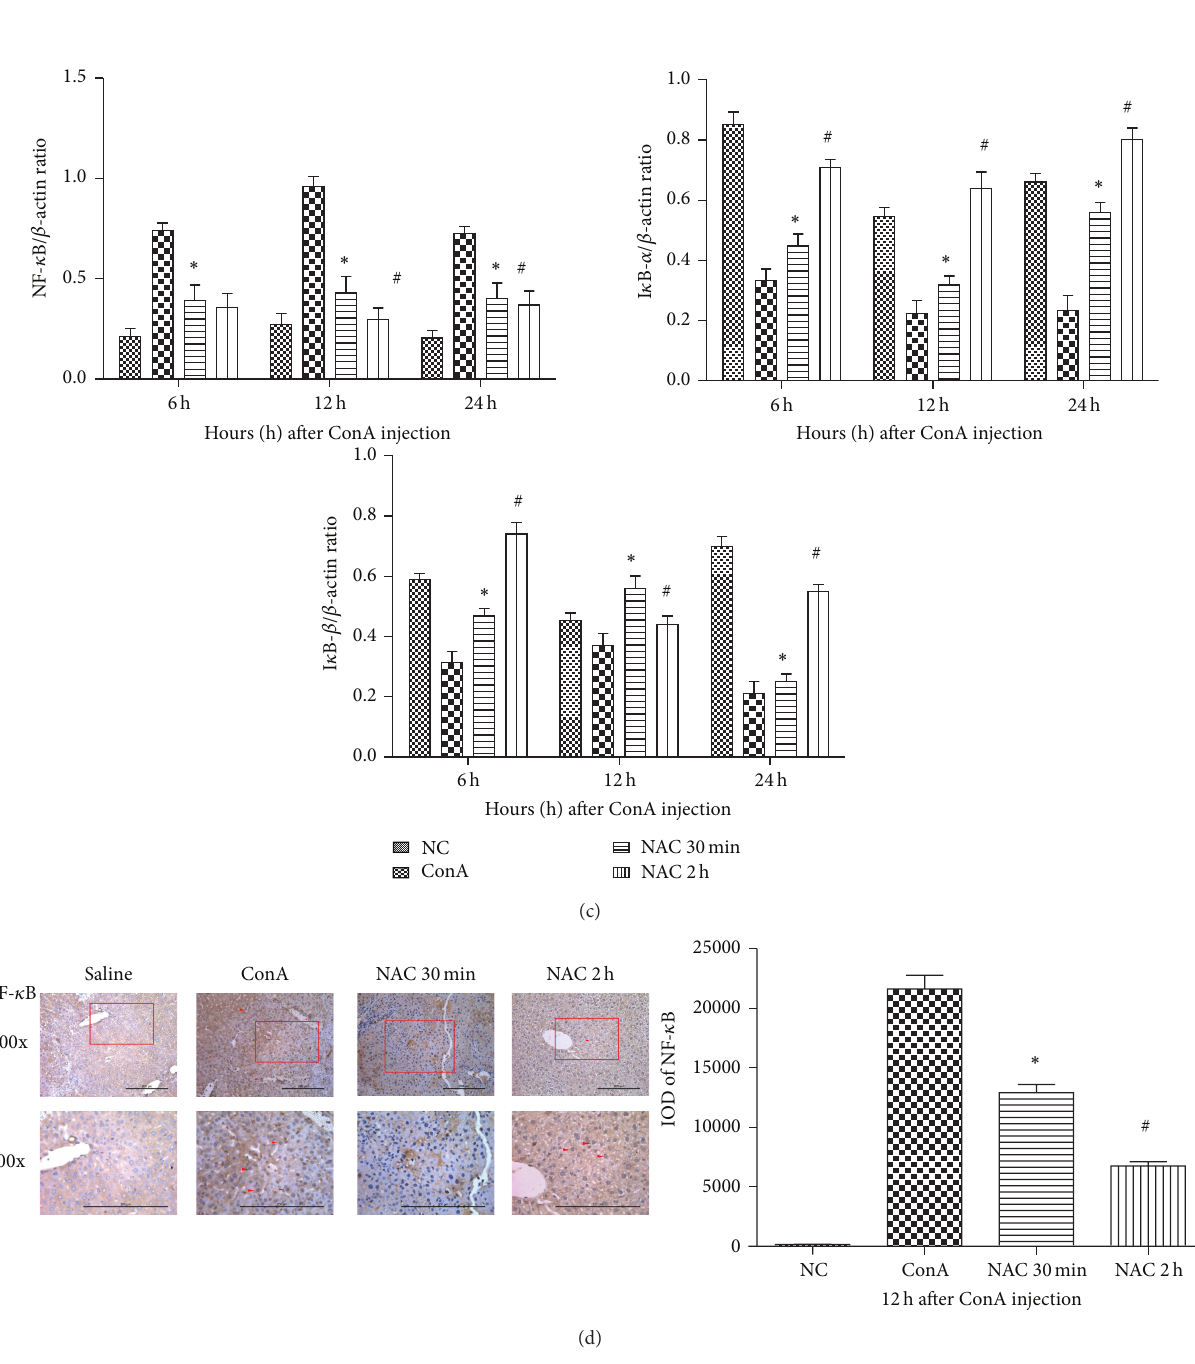
Figure 4: The effect of NAC on NF- 𝜅 B pathway in ConA-induced hepatitis in mice. (a) The expressions of NF- 𝜅 B, I 𝜅 B- 𝛼 , and I 𝜅 B- 𝛽 on mRNA levels were detected by real-time PCR. Data are expressed as mean ± SD ( 𝑛 = 6 ; ∗ 𝑃 < 0.05 for ConA versus NAC 30 min; # 𝑃 < 0.05 for NAC 30 min versus NAC 2 h). (b) The expressions of NF- 𝜅 B, I 𝜅 B- 𝛼 and I 𝜅 B- 𝛽 on protein levels were detected with western blot. (c) The results of western blot were analyzed with Quantity One. Data are expressed as mean ± SD ( 𝑛 = 6 ; ∗ 𝑃 < 0.05 for ConA versus NAC 30 min; # 𝑃 < 0.05 for NAC 30min versus NAC 2 h). (d) The expressions of NF- 𝜅 B on protein levels were detected by immunohistochemistry staining in hepatic tissues at 12h ( × 200 and × 400 magnification). The positive cells were indicated with red arrows. The result was analyzed using Image-Pro Plus 6.0. Date are showed as mean ± SD ( 𝑛 = 6 ; ∗ 𝑃 < 0.05 for ConA versus NAC 30 min; # 𝑃 < 0.05 for NAC 30 min versus NAC 2